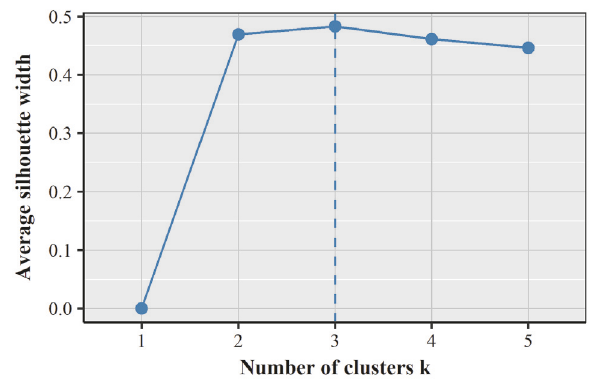
Figure 4: Optimal number of clusters; higher average silhouette widths are preferred.